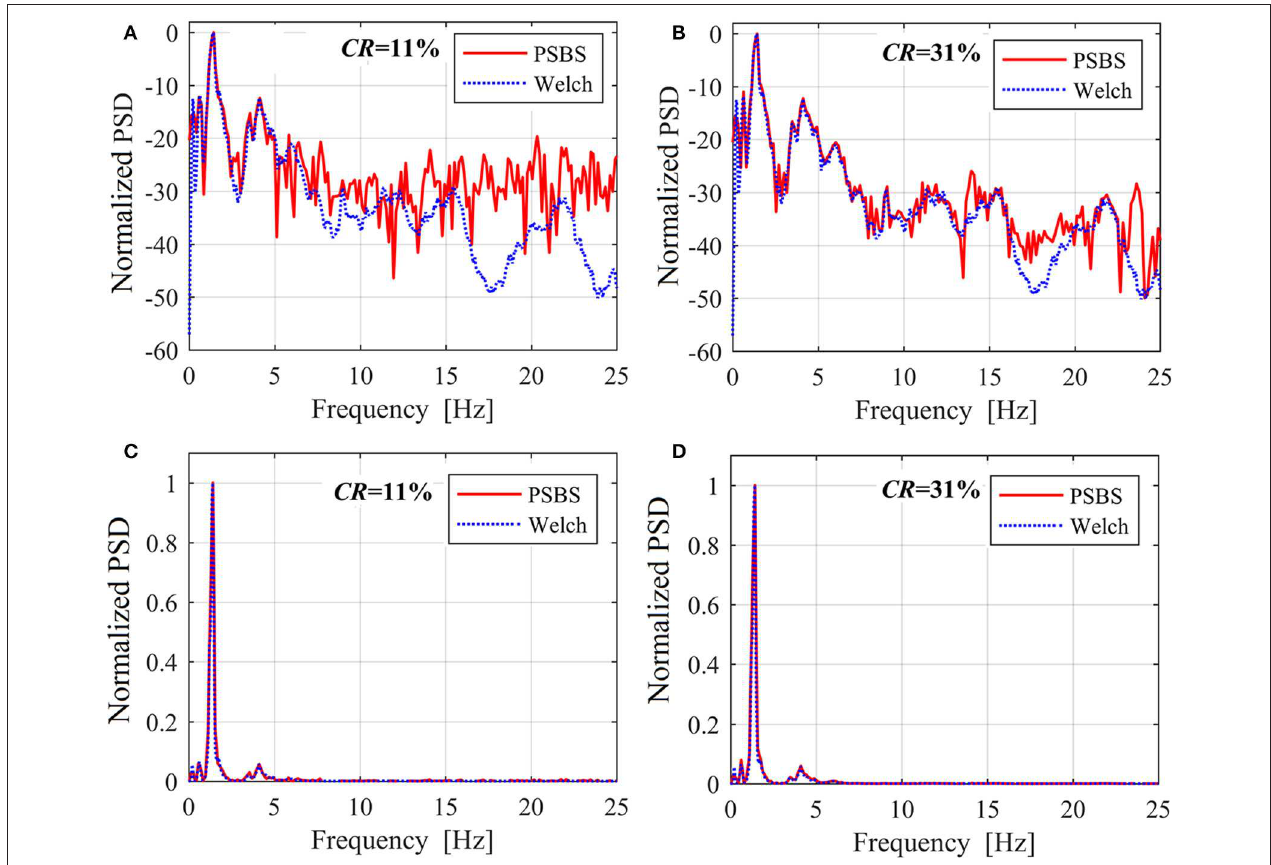
FIGURE 7 | Recovered PSDs using the PSBS approach for different CRs normalized to the peak values: (A) and (B) logarithmic (db-style) scale; (C,D) linear scale.